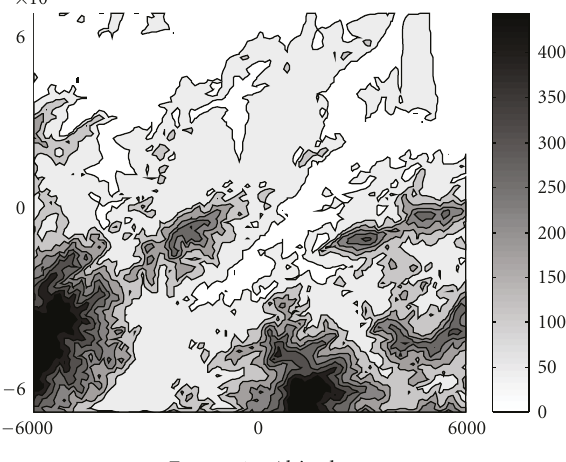
Figure 17: Altitude map. less than those of the low-tra ffi c density. The coverage rate is decreased according to the changing weight of the tra ffi c factor, from 0.9 to 0.8. As the weight of the power factor increases, the actual assigned transmit power value